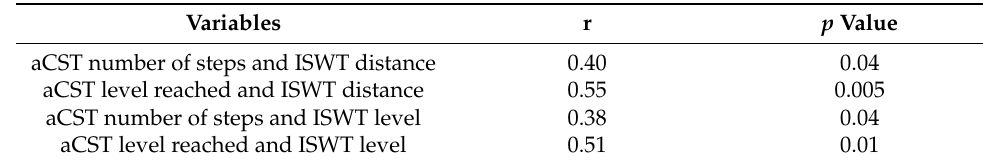
Table 3. Correlations between the best performance of the adapted Chester step test and incremental shuttle walk test.